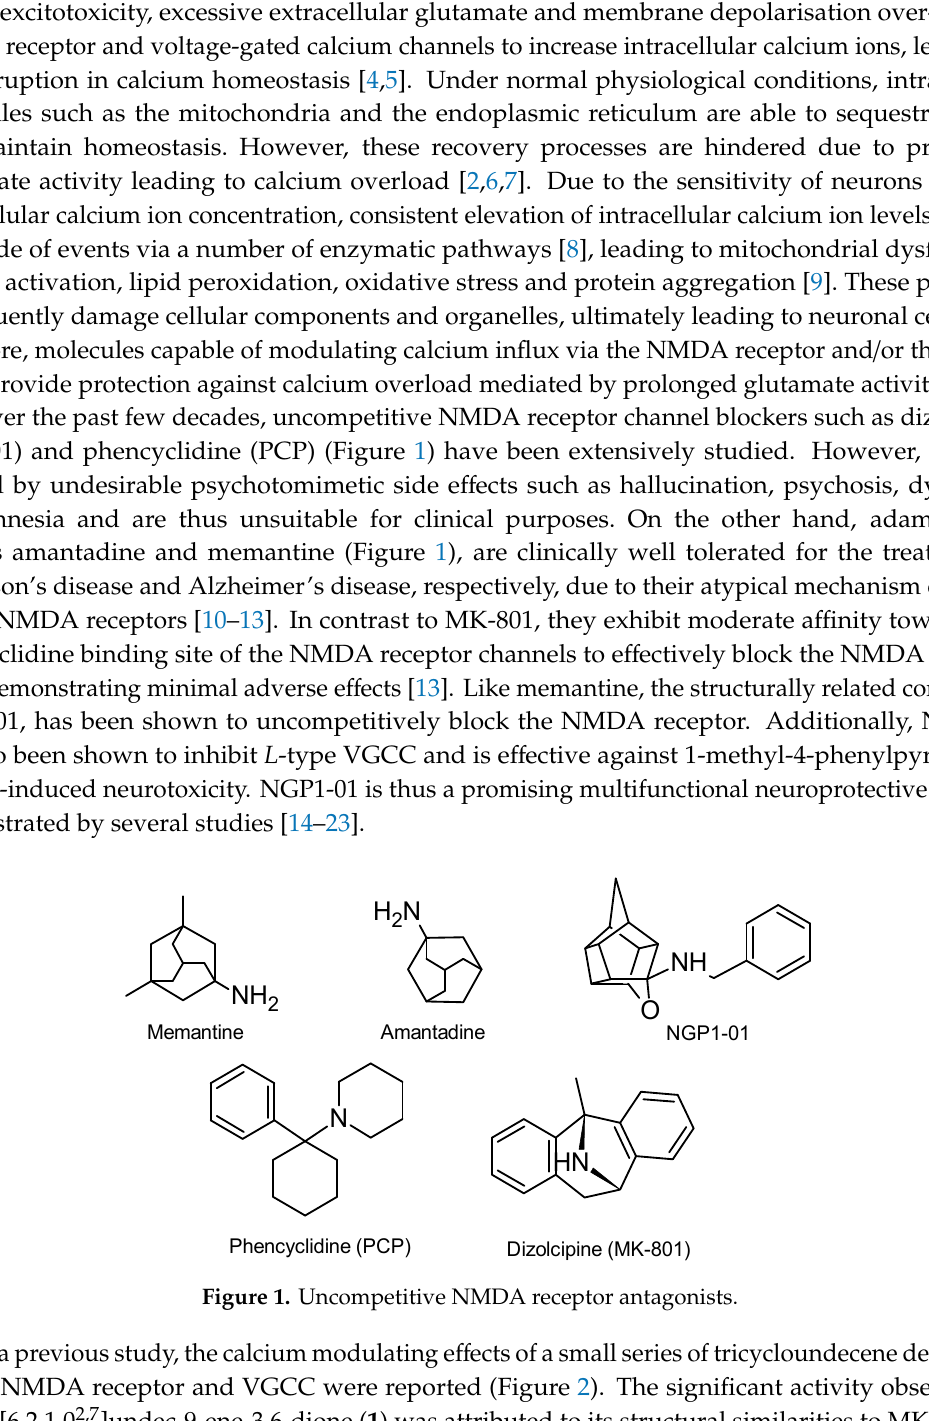
Figure 2. Tricyclo[6.2.1.0 2,7 ]undec-9-ene-3,6-dione- ( 1 ) and 4-oxatricyclo[5.2.1.0 2,6 ]dec-8-ene-3,5-dione ( 2 ) scaffolds.